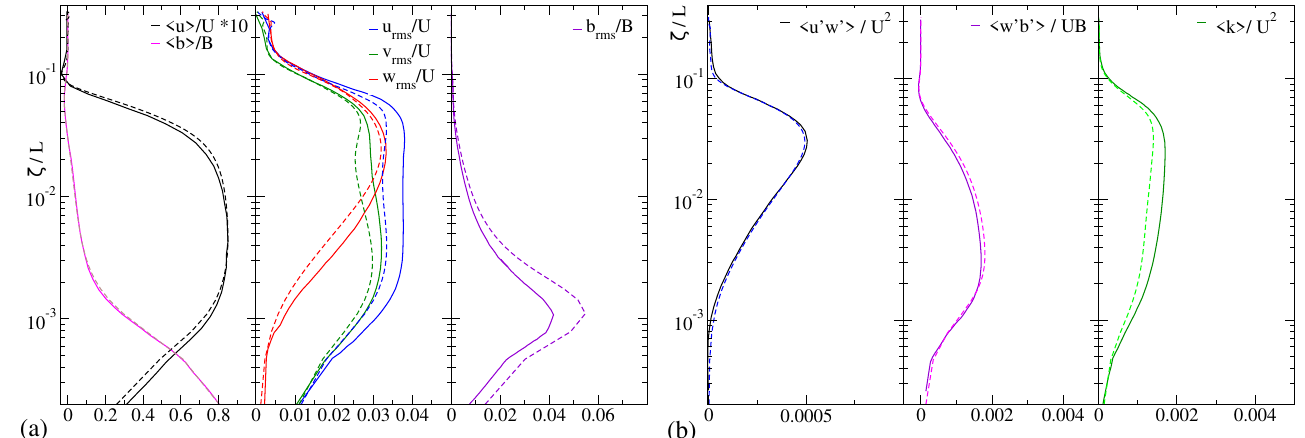
Figure 2. Non-dimensional average quantities along a slope-normal line. Solid lines, DNS by [43]; dashed lines, present LES. Left panel ( a ): streamwise velocity u and buoyancy b , root-mean-square of velocity components, and root-mean-square of buoyancy force. Right panel ( b ): turbulent kinematic momentum flux u (cid:48) w (cid:48) , turbulent buoyancy flux w (cid:48) b (cid:48) and turbulence kinetic energy k .